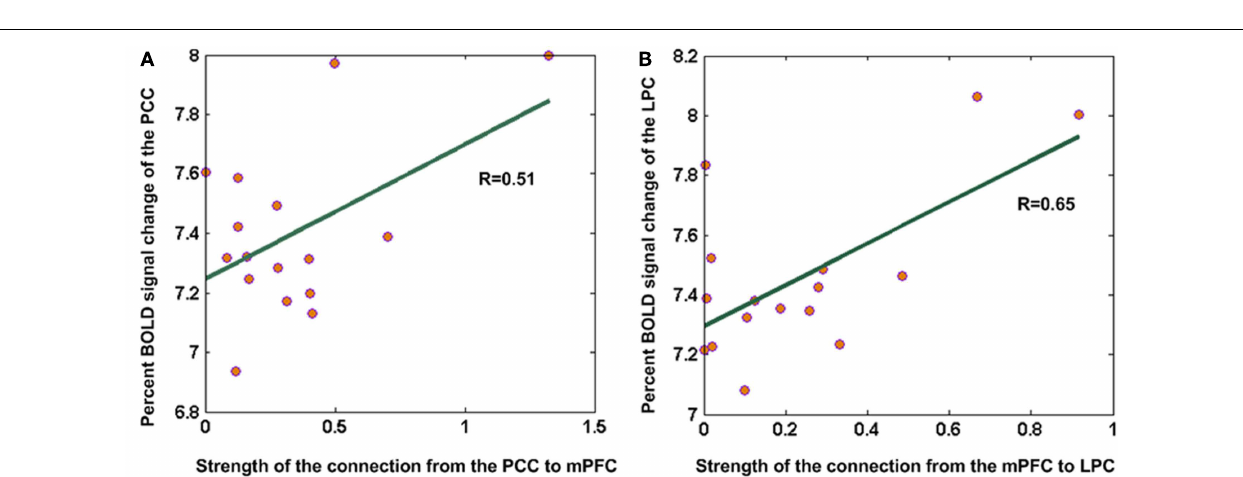
FIGURE 7 | Correlation between regional BOLD signal changes and effective connection strengths within the DMN. (A) Percent BOLD signal change in the PCC was significantly ( p = 0.04) correlated with the strength of